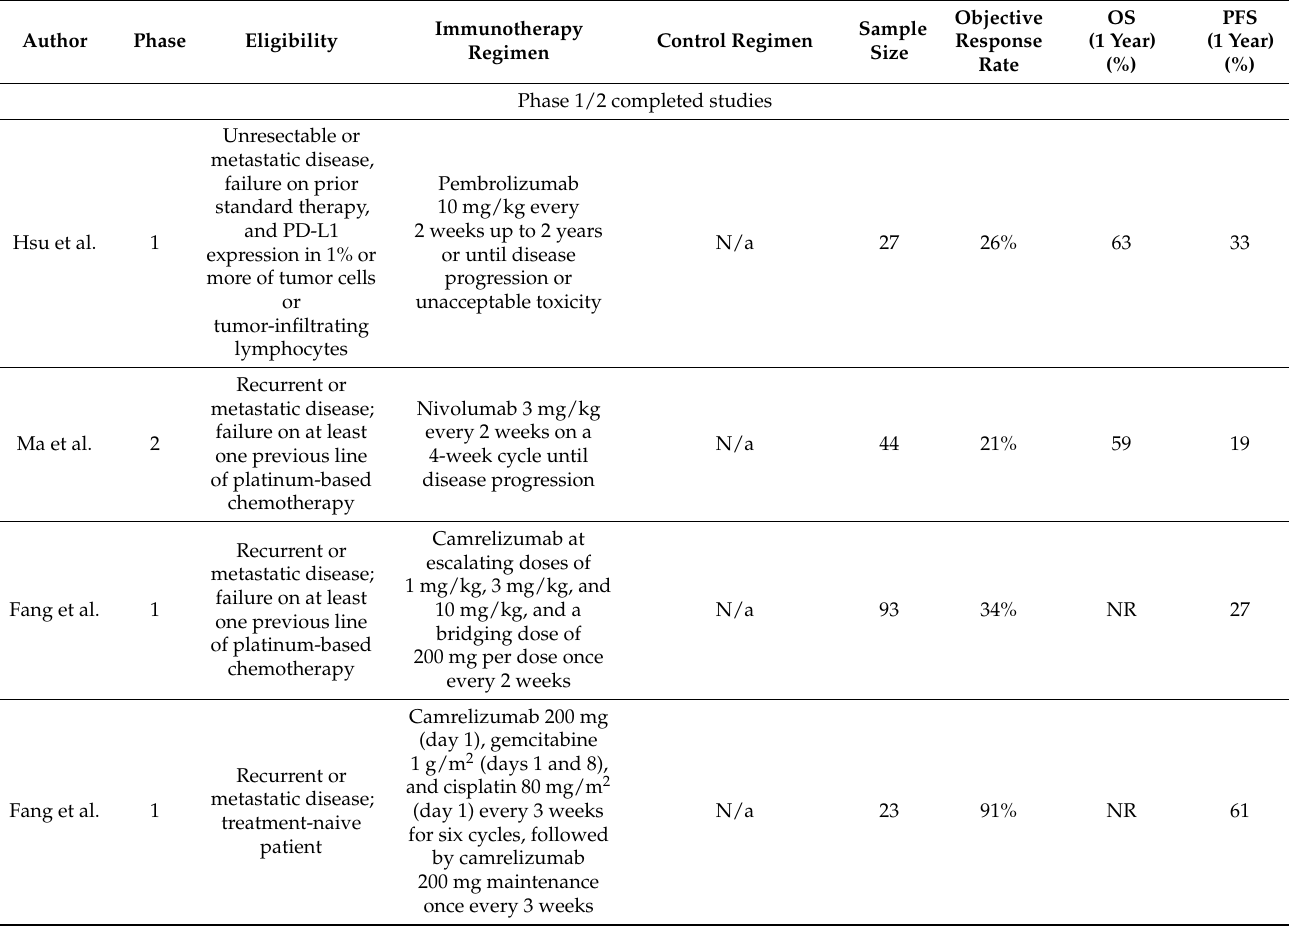
Table 1. Compilation of completed and ongoing phase 1–3 clinical trials investigating efficacy of immunotherapy in advanced